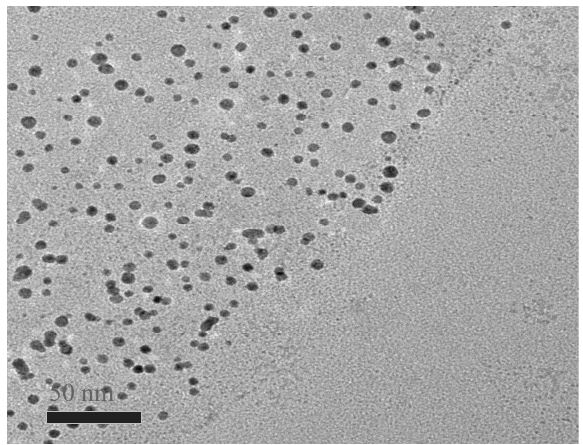
Figure 3. The TEM image of TCPP–Gr/AuNPs.